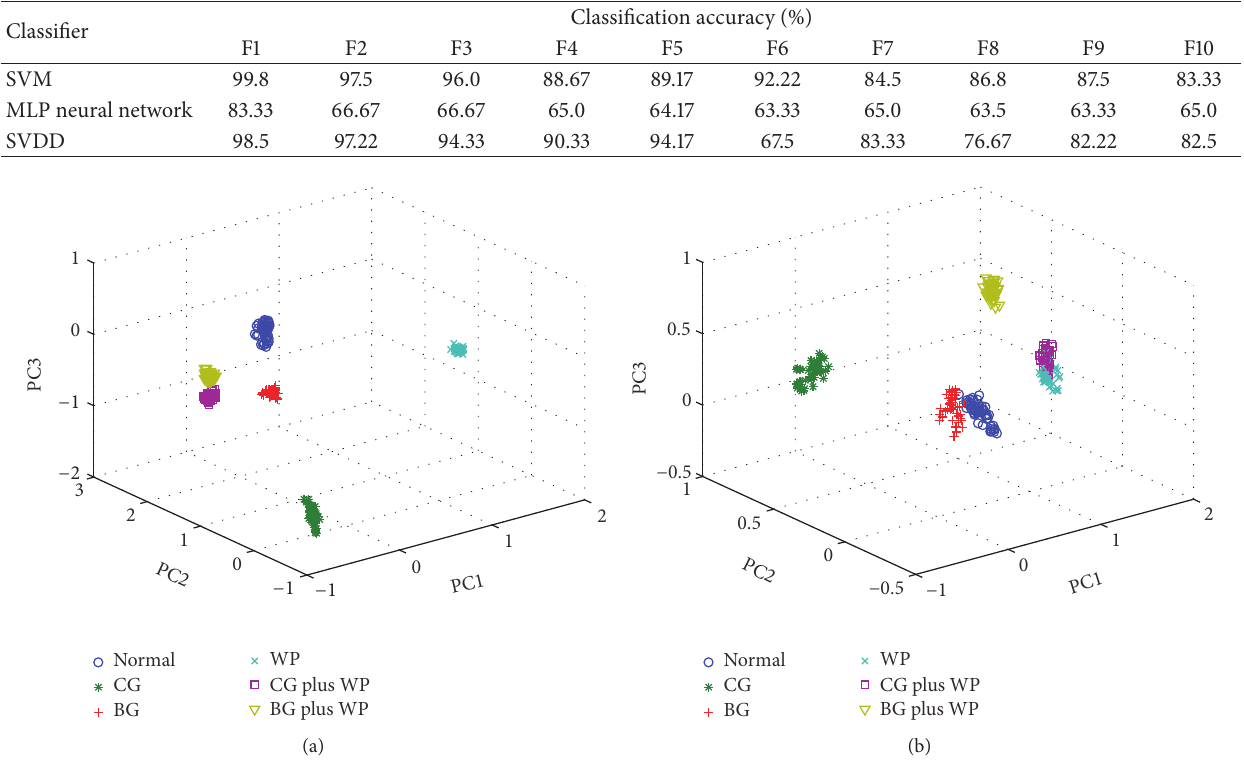
Figure 6: Scatter plots of dimension reduction results based on LPP with different input data: (a) LPP-VM and (b) LPP-VS.